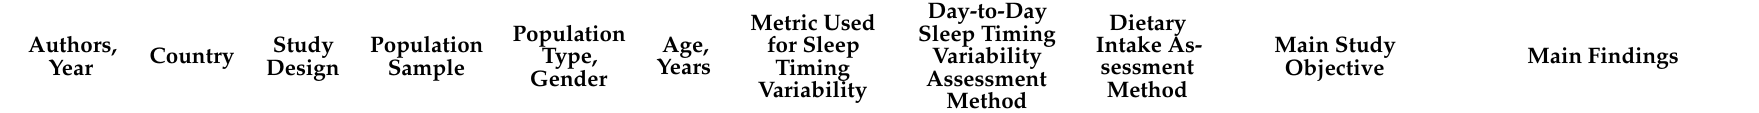
Table 3. Studies reporting the association of day-to-day variability in sleep timing with dietary intake and meal